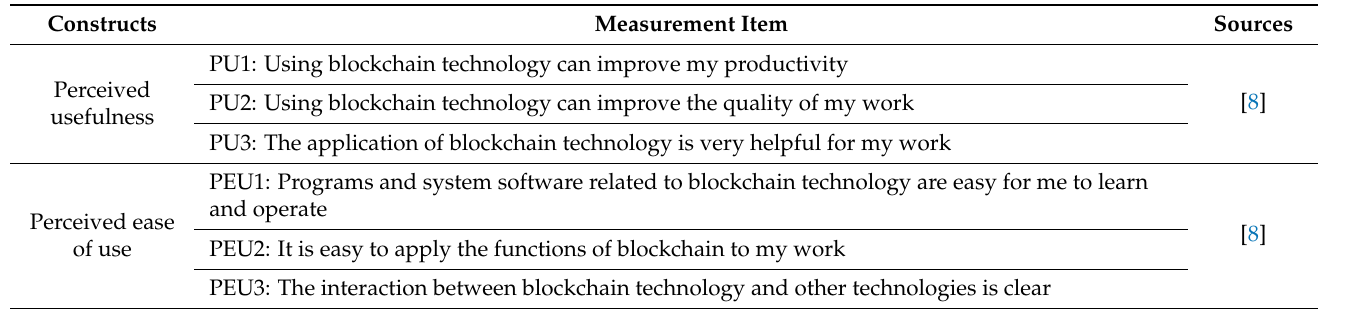
Table 1. Measurement